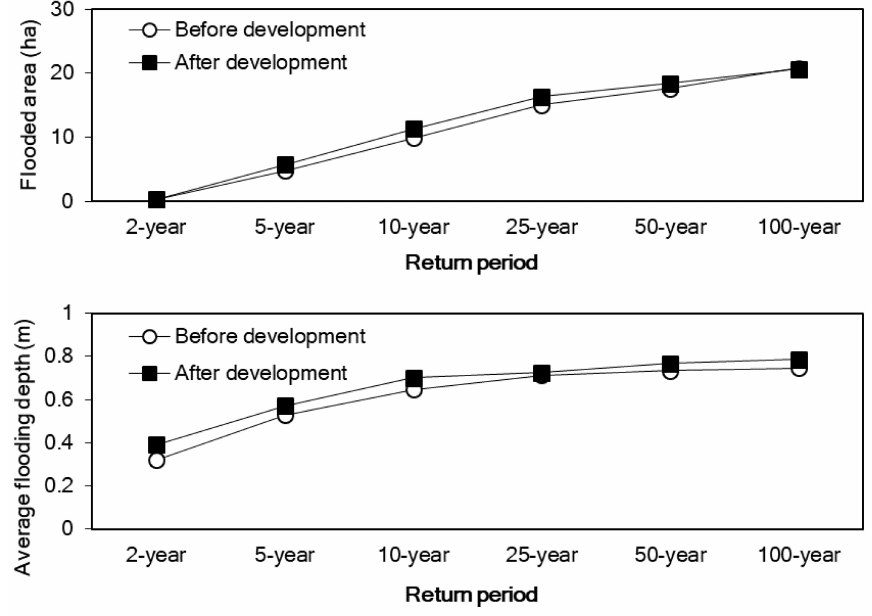
Figure 9. Comparison of flooding range and average flooding depth of various return periods before and after land development in the southern area of the development